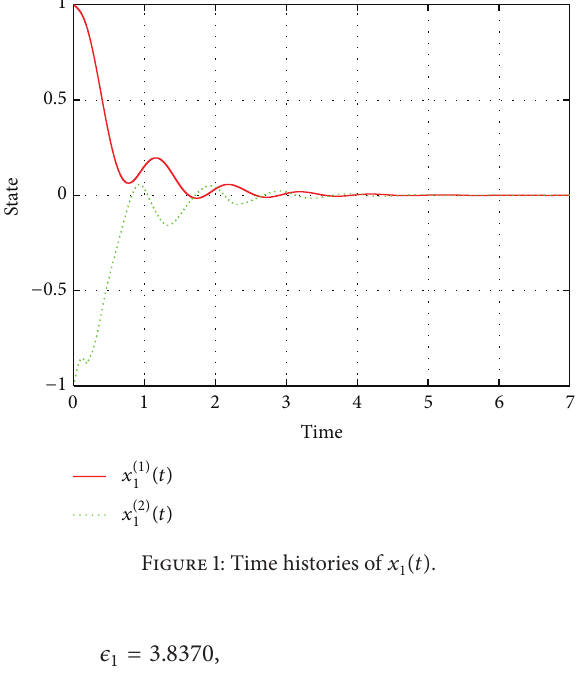
Figure 1: Time histories of 𝑥 1 (𝑡)